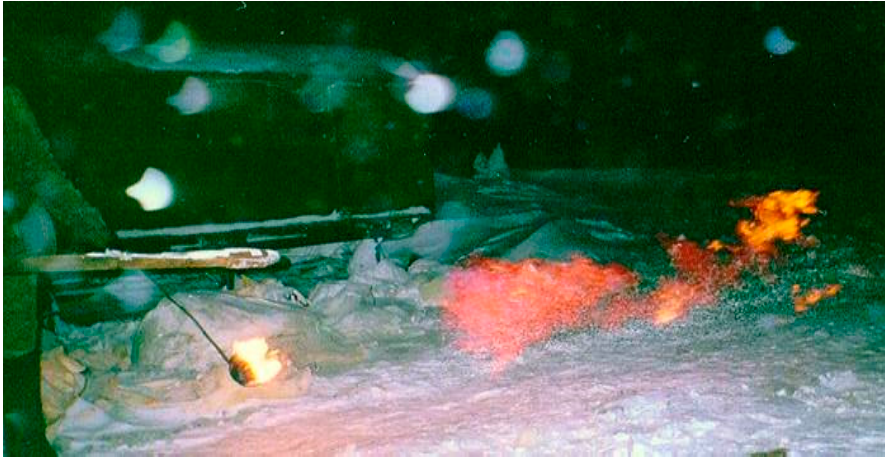
Figure 9. Release of intrapermafrost gas from a depth of 64 m in a test borehole. Bovanenkovo field. Photograph by Kondakov (number on the map: 19).